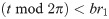
Influence of forcing.a) Forcing function Φ(t) for the modified deterministic Tero–Kobayashi model with intermittent lighting and parameters br1 < br2 and β1 < β2. Solid lines show the instantaneous forcing Φ1(t) (red) and Φ2(t) (blue), dashed lines are for the time-averaged forcing as denoted by the angle brackets 〈⋅〉. b) Attractors (markers) and basin of attraction (shaded) for the stable equilibrium with both D1 ≠ 0 and D2 ≠ 0 of the deterministic model. Squares are for the unforced model (tmod2π)<br1 (dark/dark), circles are for br1<(tmod2π)<br2 (light/dark), stars are for br2<(tmod2π) (light/light). Filled symbols denote stable equilibria, hollow symbols stand for unstable equilibria. The shaded region denotes the basin of attraction for the unforced model. The basins of attraction for the forced models are between the corresponding red lines (light/dark) and blue lines (light/light), respectively. The unshaded regions left/right respectively above/below these lines are the basins of attraction for convergence on a single path (D1 = 0 or D2 = 0). We assume here the model is locked forever into the respective forcing regime.